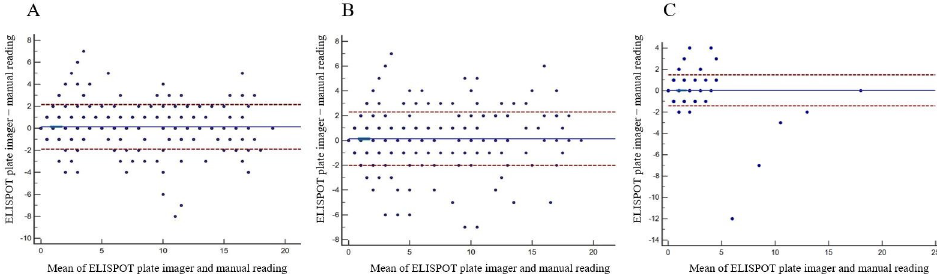
Fig 1. Bland–Altman plot of spot count differences between the technicians’ manual reading and ELISPOT plate imager. (A) Spot count differences in panel A; (B) spot count differences in panel B; (C) spot count differences in nil control. The horizontal solid lines (blue color) indicate the mean spot count difference, and the dashed lines (red color) represent the ± 1.96 SD limits from the mean spot count difference.